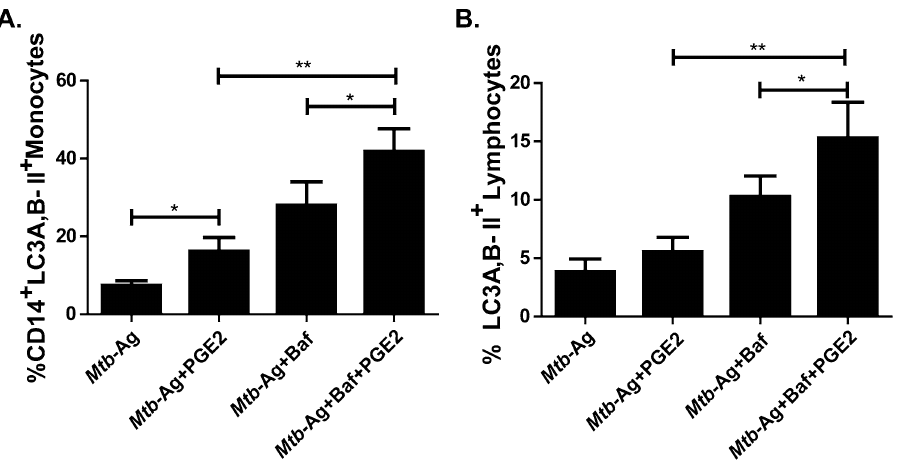
Figure 5. Autophagy flux in cells treated with PGE2. Peripheral blood mononuclear cells (PBMC) from tuberculosis patients (n = 6) were incubated at 2 × 10 6 cells/ml for 16 h to allow adherence of monocytes. Afterwards, the cells were stimulated with Mtb -Ag (10 µg/ml) in the presence or absence of PGE2 (2 µM) for 16 h. To evaluate autophagy flow, Bafilomycin A1 (Baf A1, 1 µg/ml) was added in the last 2 h of culture before determining the autophagy levels by flow cytometry by means of indirect intracytoplasmic staining of LC3A, B-II resistant to saponin in ( A ) CD14 + monocytes and ( B ) lymphocytes. The bars represent the mean values of the percentage of LC3A, B-II cells ± SEM . * p < 0.05, ** p < 0.01. P values were calculated using one-way ANOVA and Tukey post hoc multiple comparison